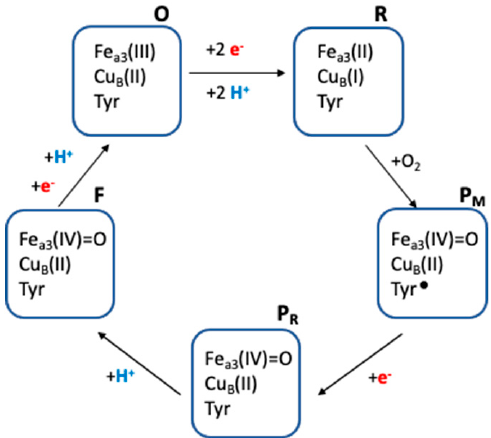
Figure 1. Structure of the catalytic heme a 3 -Cu B center of bovine cytochrome c oxidase. His376 is bound to the iron of heme a 3 (green sphere). Cu B (cyano sphere) is coordinated by His291, His290 and His240. A covalent bond is present between His240 and Tyr244 (PDB. ID: 1V54).